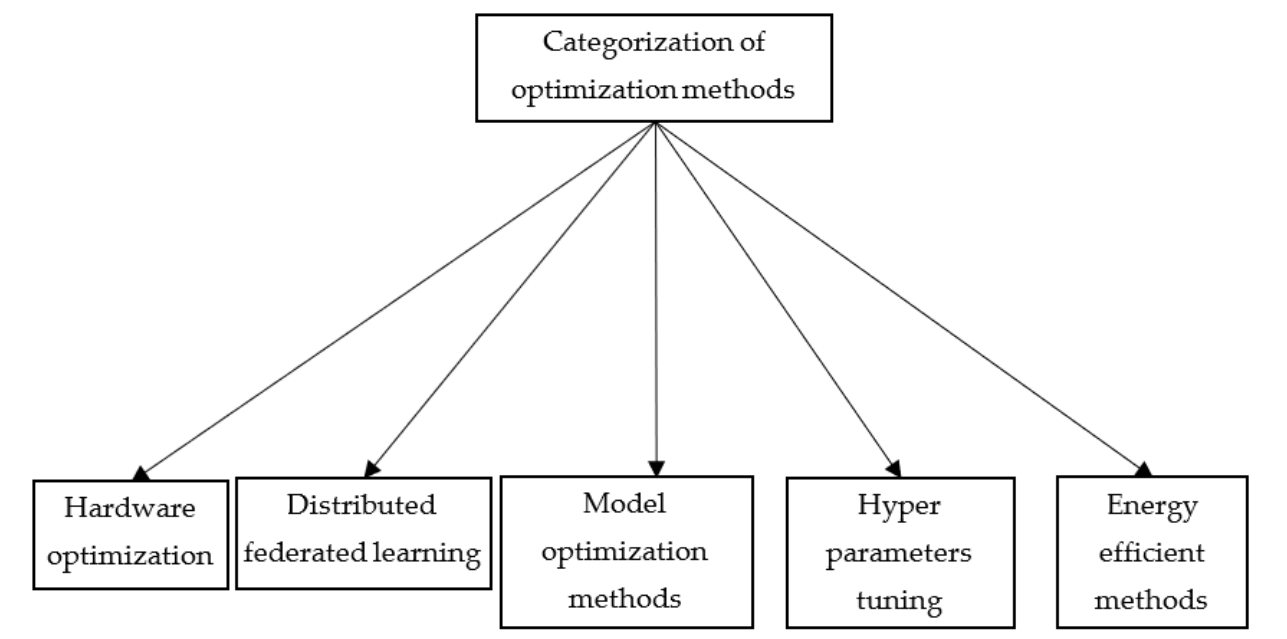
Figure 3. Categories of optimization methods.